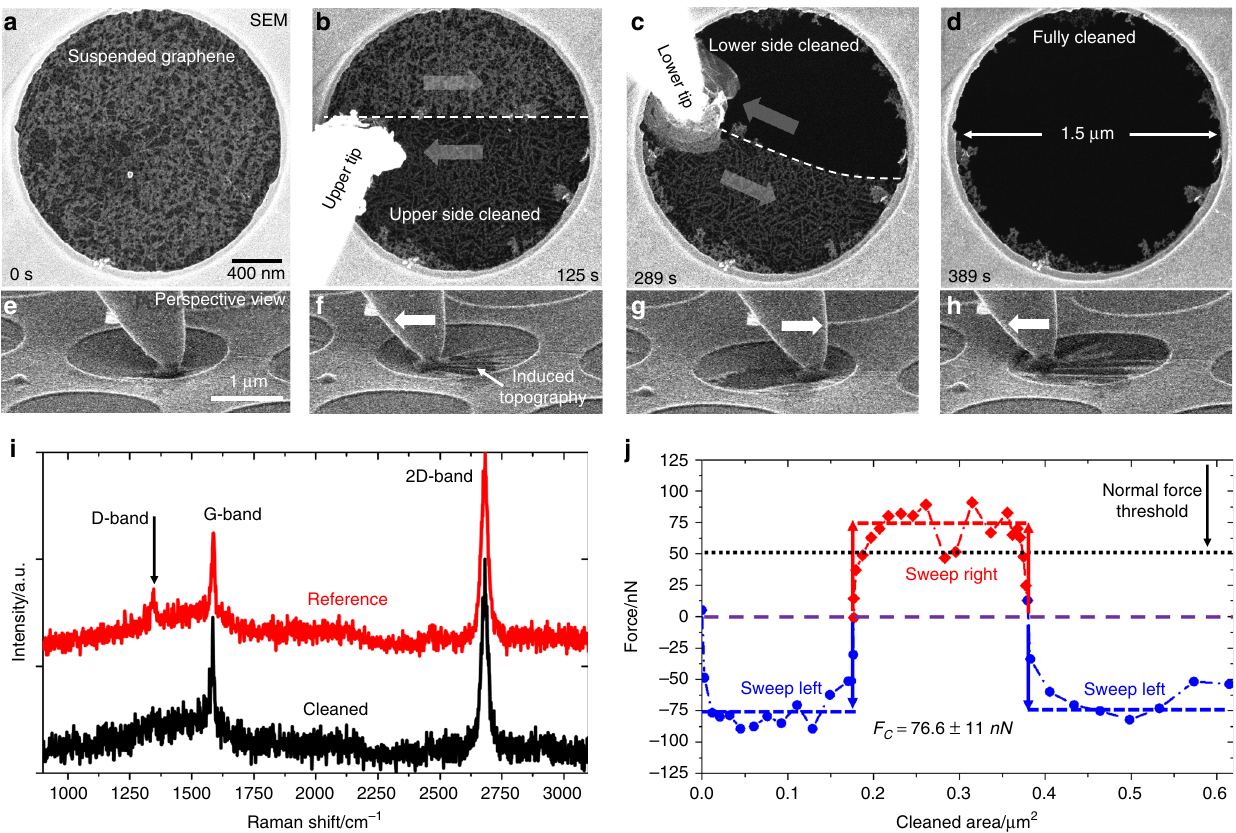
Fig. 2 In situ mechanical cleaning procedure in SEM. a A suspended graphene membrane with residual contamination as seen in SEM. By lateral movement of a fi ne tip, the contamination can be removed fi rst from one side ( b ) and subsequently from the other side ( c ). After the process, a fully cleaned membrane is obtained ( d ). e – h Perspective view of the cleaning process (one side only) showing the introduction of topographic wrinkles in the membrane. The full cleaning process can be viewed in Supplementary Movies 1a, b. Raman spectroscopy ( i ) shows no increase in D-band intensity due to the cleaning process and no shift of the band positions. j The lateral force required for cleaning was found to be in the range of 76 nN with a minimal normal force of ~50